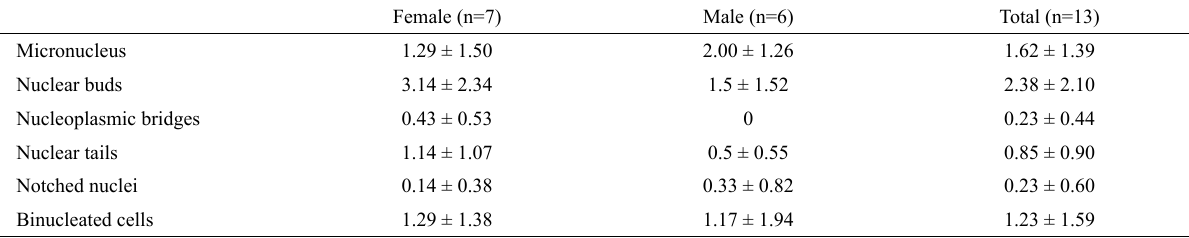
Table 1 - Sample size and frequency of nuclear abnormalities in erythrocytes (2,000 cells) of Falco peregrinus.